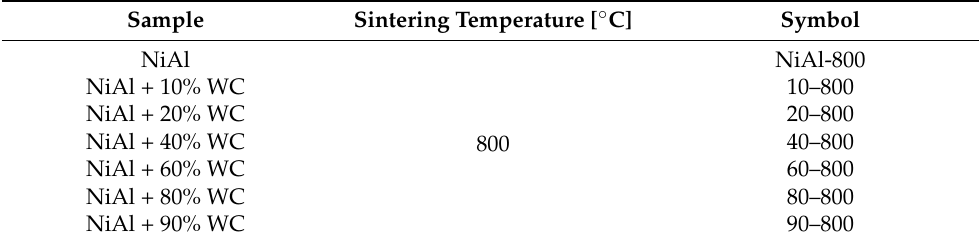
Figure 2. Schematic illustration of the hot-pressing process. Table 1. Bulk sample